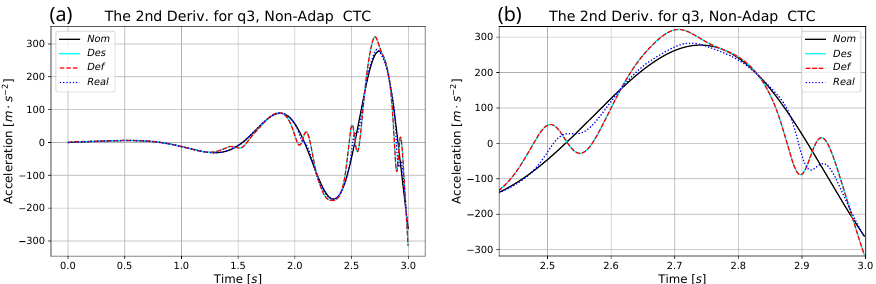
Figure 18. Second time derivatives for q 3 ( a ) and the zoomed-in excerpts ( b ) for the non-adaptive CTC controller using the identified parameters. The results of the simulation investigations generate conclusions detailed in Section